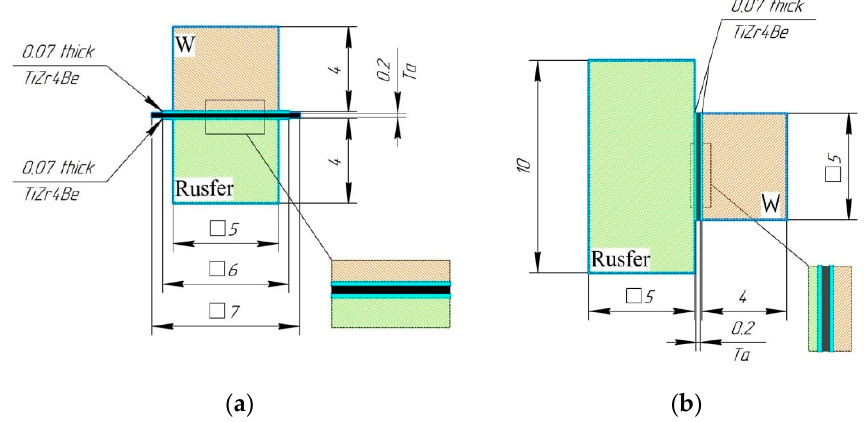
Figure 1. Schematic view of a brazed specimen (dimensions in mm): ( a ) the sample for microstructural observation; ( b ) the shear test sample.